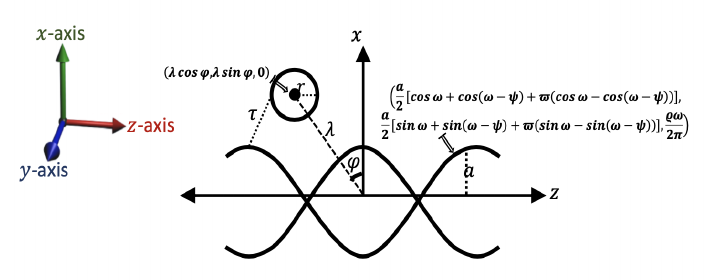
Figure 2. Geometric parameterization of a cisplatin molecule that is binding to dsDNA. In addition, the Cis molecule is assumed to be at a distance λ from the z -axis of the dsDNA; thus, the coordinates of the center of the Cis molecule are given as ( x , y , 0 ) , which may be expressed in terms of the distance λ in the radial direction and a polar angle ϕ